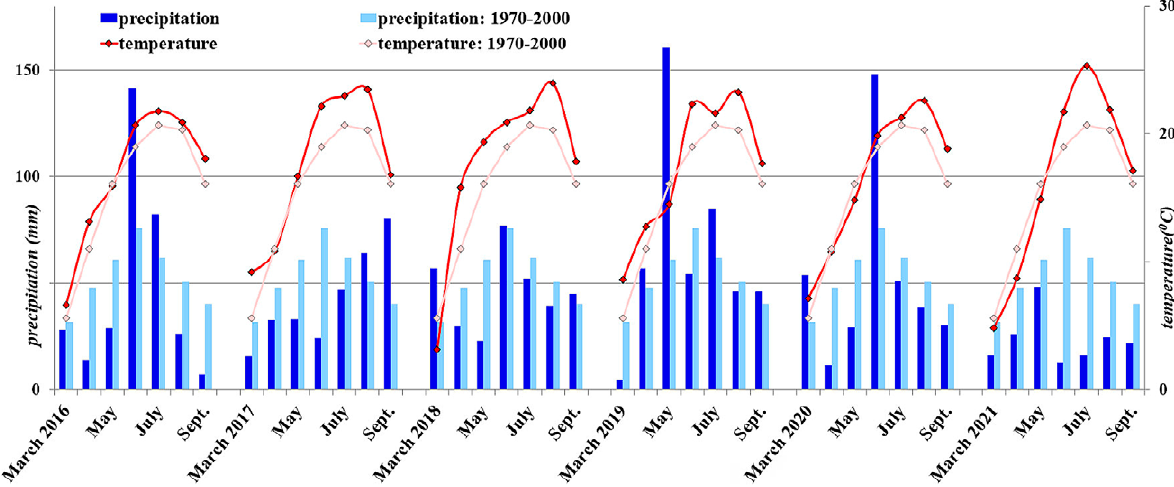
Figure 2. Precipitation and temperature in Békéscsaba station in the period of 2016–2021 Data: Ogimet.com ( http://www.ogimet.com/gsynres.phtml.en) ; Operatív Vízhiány Értékelő és Előrejelző Rendszer (